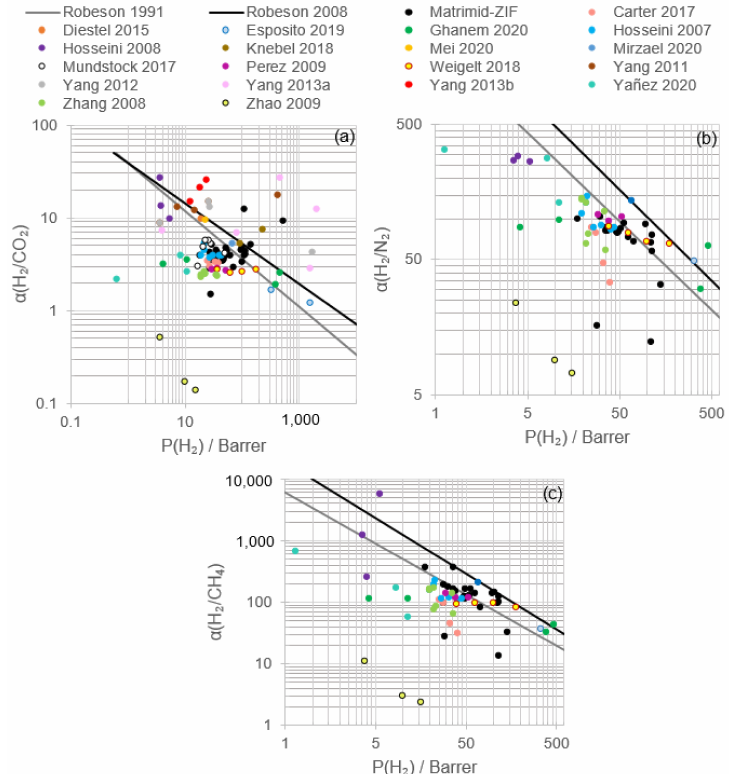
Figure 8. Robeson plot for ( a ) H 2 /CO 2 , ( b ) H 2 /N 2 and ( c ) H 2 /CH 4 gas permeation tests through modified Matrimid ® /ZIF MMMs. Matrimid-ZIF refers to the results included in Figure 6 after ZIF addition to pristine Matrimid. Reference correspondence is found in Table